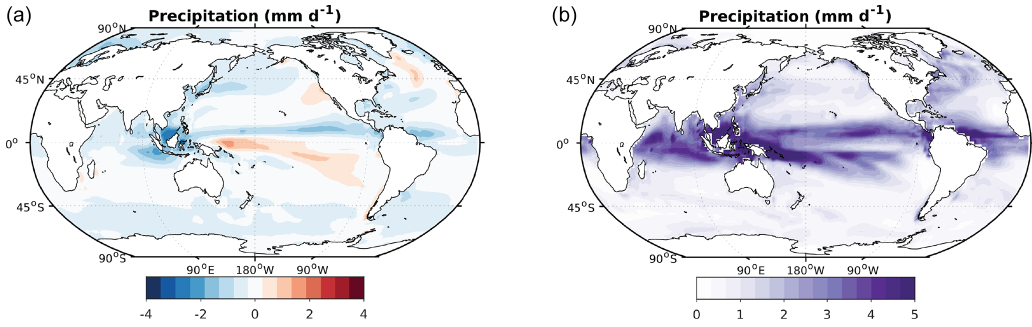
Figure 4. Annual mean precipitation lgm–piControl anomaly (a) and model spread (b) (in mmd − 1